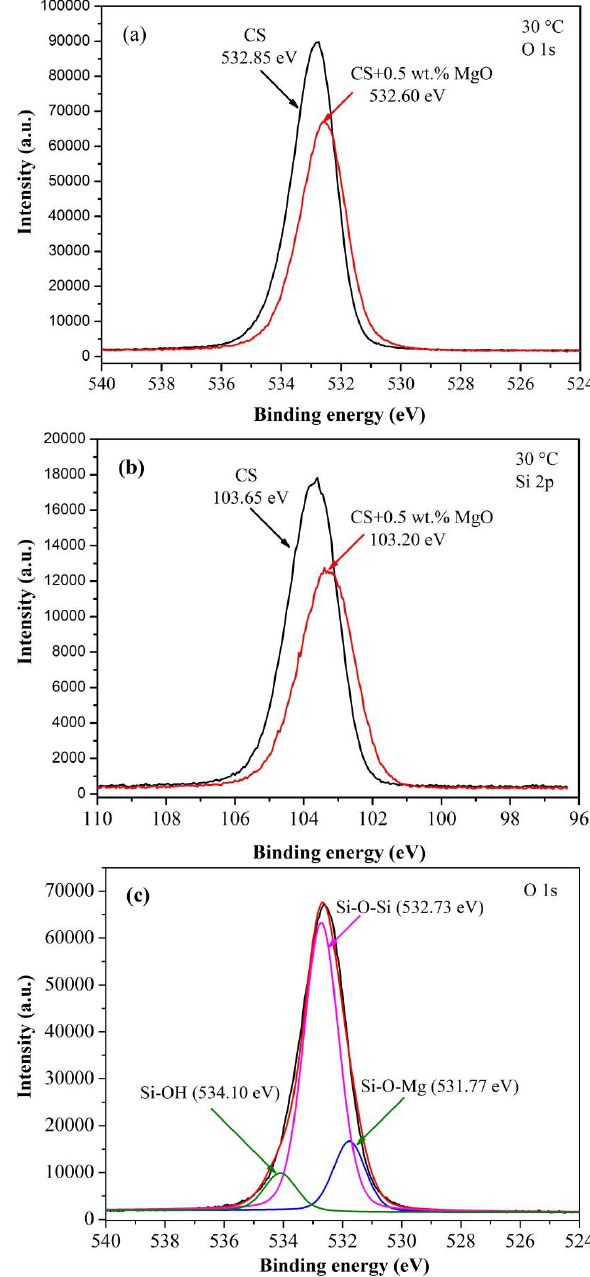
Figure 4: O 1 s (a) and Si 2 p (b) XPS spectra for colloidal silica with and without magnesia, and the peak fitting of O 1 s spectrum for colloidal silica with 0.5 wt.% MgO